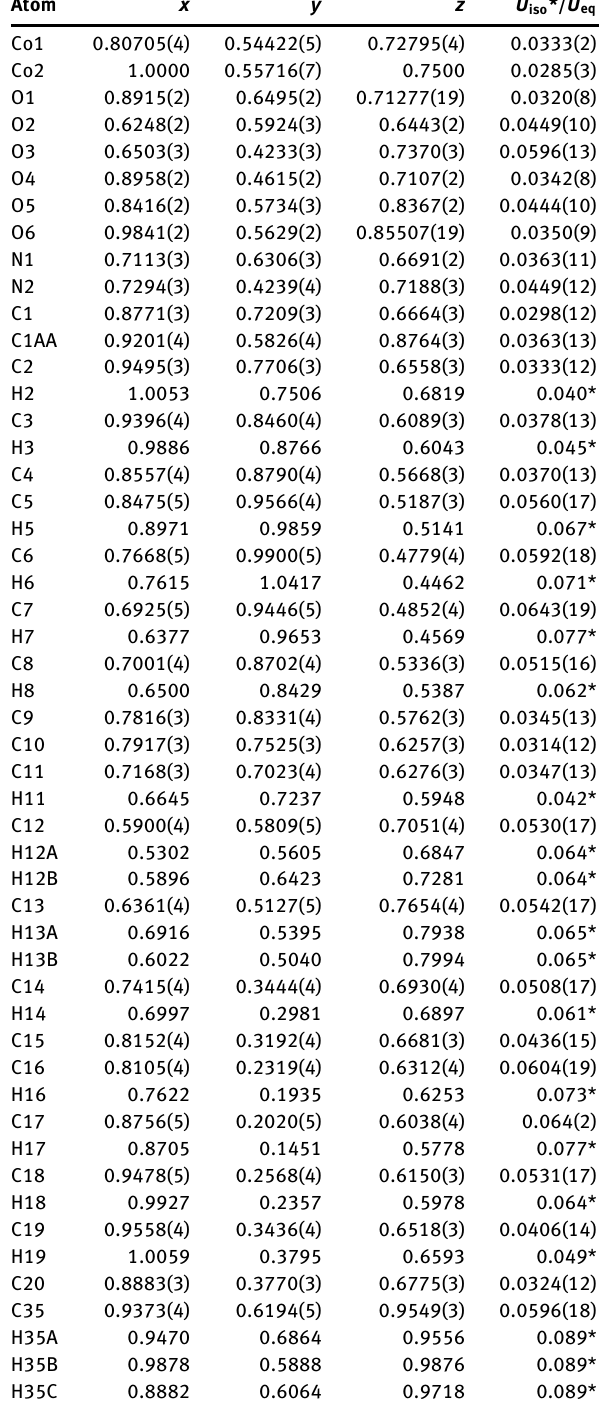
Table 2: Fractional atomic coordinates and isotropic or equivalent isotropic displacement parameters (Å 2